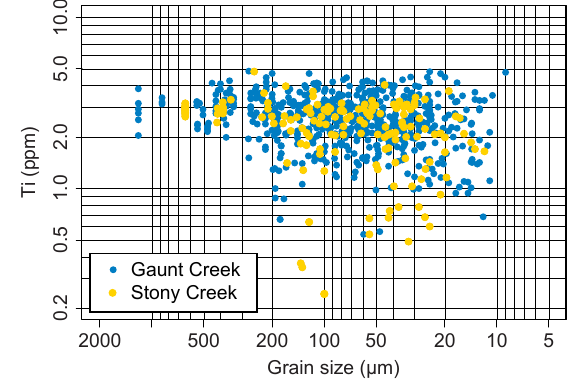
Figure 6. Plot of Ti concentration vs. grain size for all